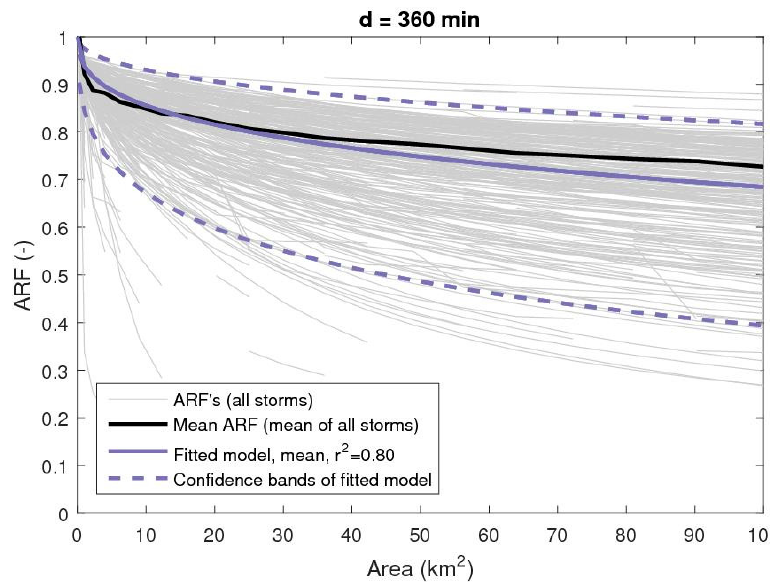
Figure 4. Aerial reduction factors ( ARF) for durations of 60 min. Dashed lines are the confidence limits (mean +/ − std. dev.) of the fitted ARF .